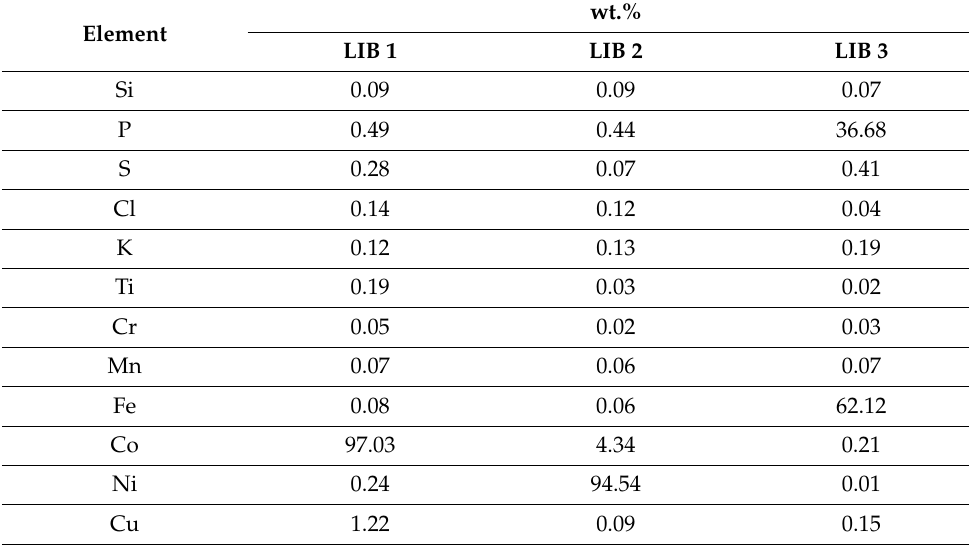
Table 1. Composition of the surface of cathode materials determined by XRF.